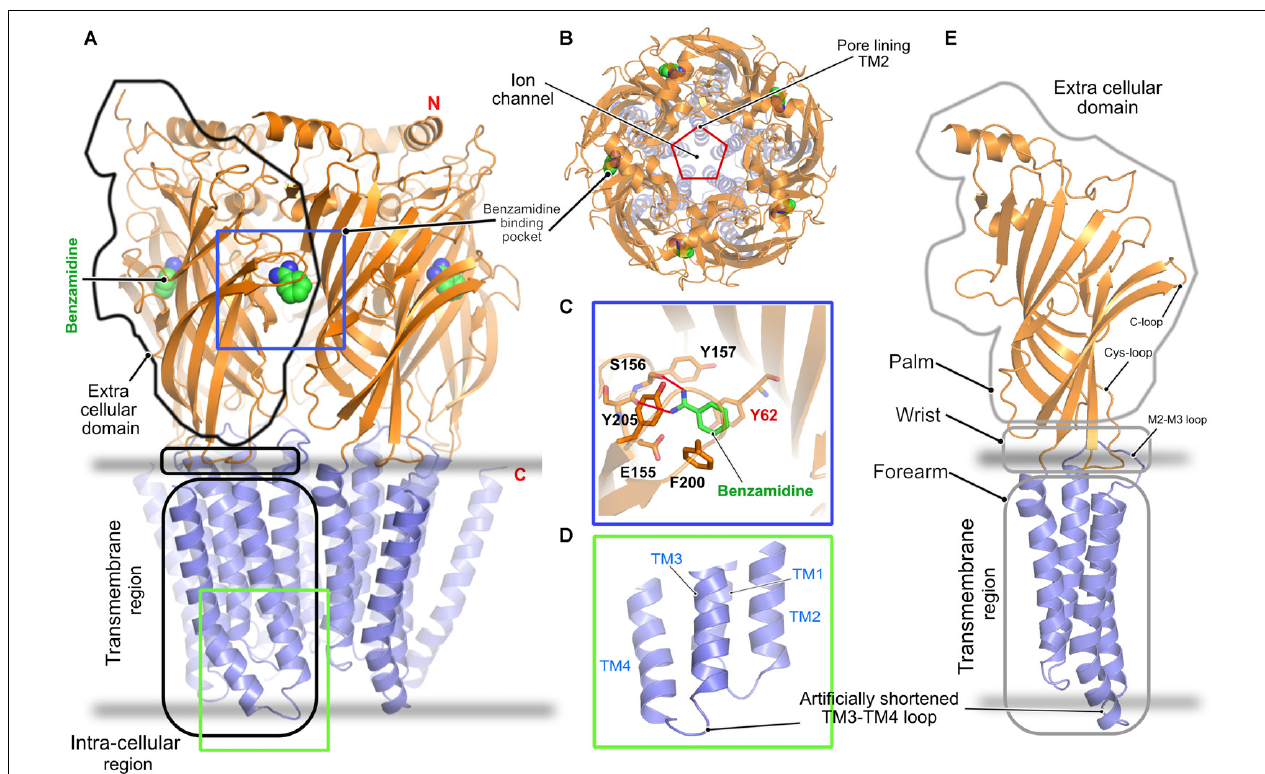
FIGURE 3 | Architecture of the homopentameric GABA A R. (A) Crystal structure of the GABA A R β 3 homopentamer in the desensitized state displayed in cartoon with the bound benzamidine in space filling representation (PDB: 4COF). (B) Top view of the receptor displaying the ion channel lining contributed by TM2. (C) Enlarged view of the agonist benzamidine (green) binding pocket where the bound ligand and crucial residues are shown in stick representation. (D) Enlarged view of the intracellular loops connecting the TM helices displaying the artificially shortened TM3-TM4 loop which aided in structure determination. (E) Cartoon representation of a GABA A R β 3 monomer showing its relationship to a left